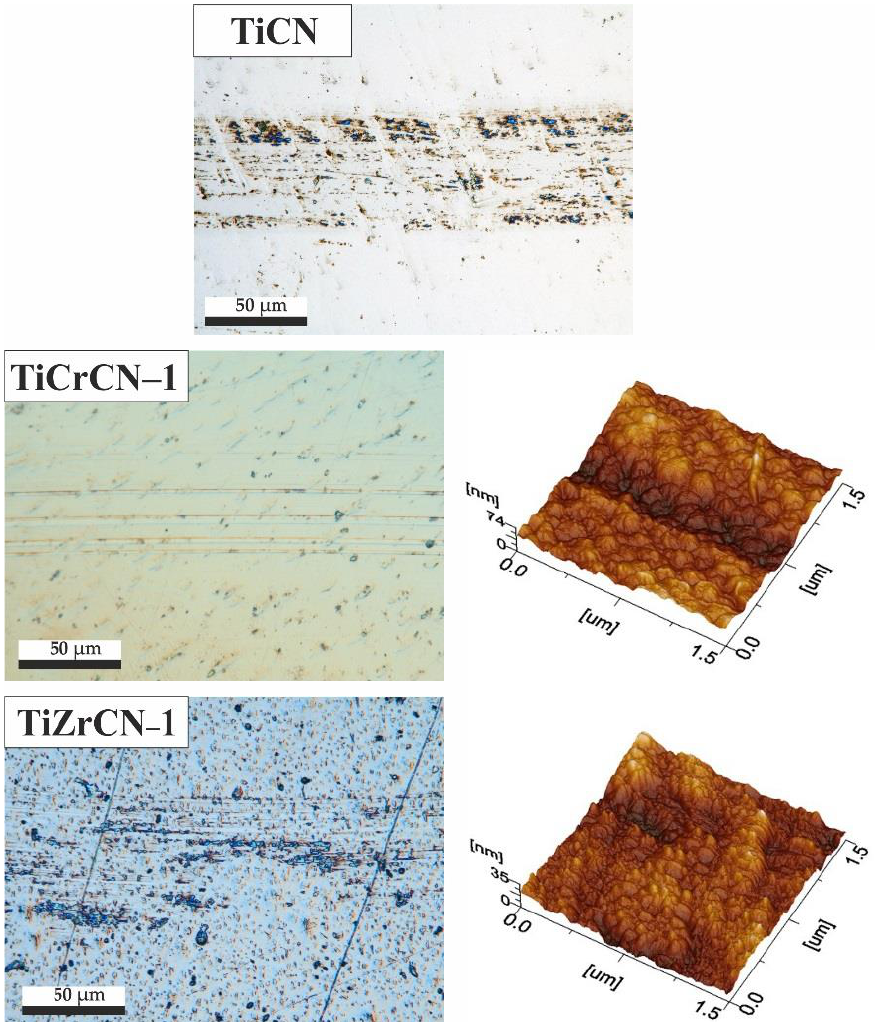
Figure 7. Optical micrograph and SPM images of the wear track of coatings after tribological tests.